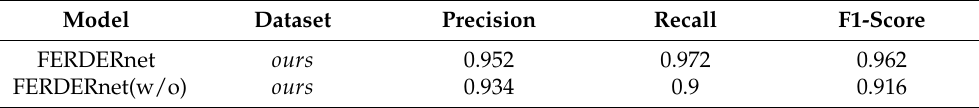
Note: ours stands for on-road driver facial expression